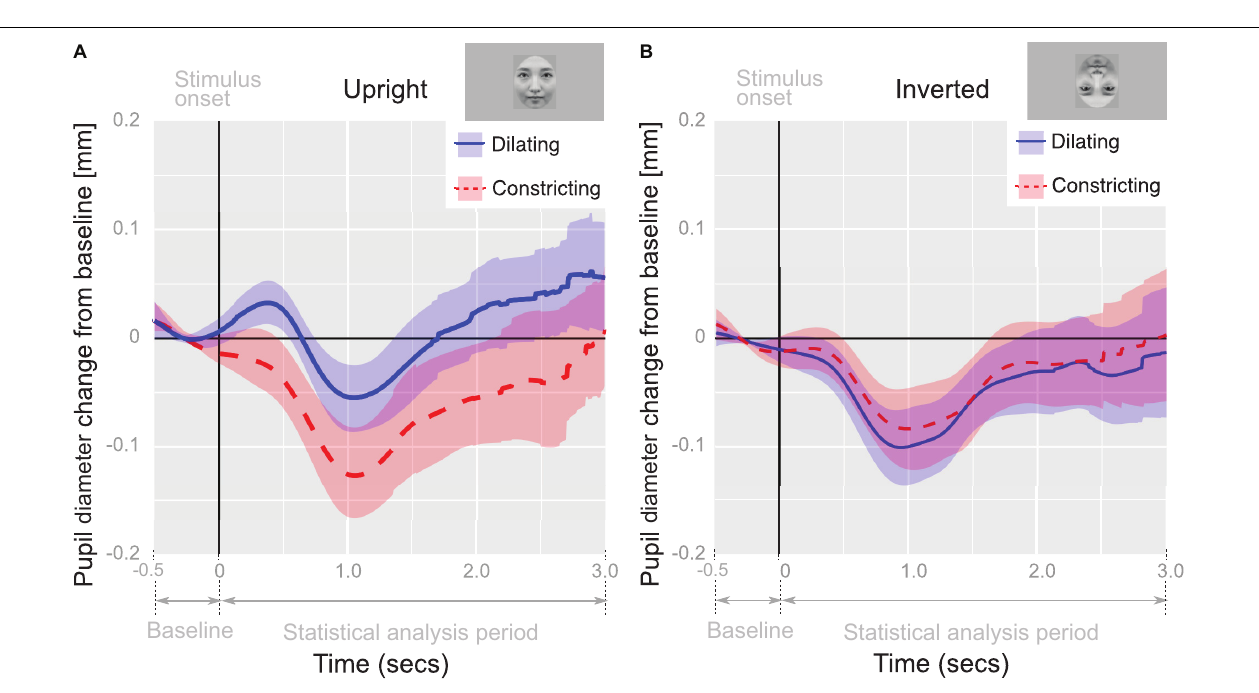
FIGURE 2 | Average heat maps of infants’ gaze to stimuli and mean percentages of gaze on AOIs. (A) Average heat maps of infants’ gaze to stimuli in (a) the Dilating/Upright, (b) the Constricting/Upright, (c) the Dilating/Inverted, and (d) the Constricting/Inverted condition, respectively. White circles indicate AOIs. (B) Blue and red bars represent the dilating and constricting conditions, respectively. Error bars indicate standard errors. Mean percentage of the gaze on AOIs was higher in upright condition than in inverted condition ( p < 0.01).